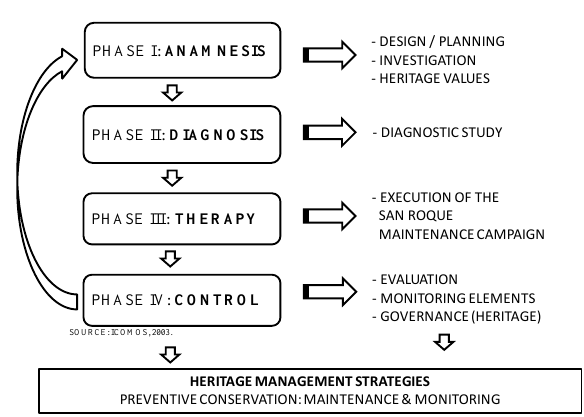
Figure 1: Phases of the Preventive Conservation Plan applied in the San Roque Maintenance Campaign Source: ICOMOS